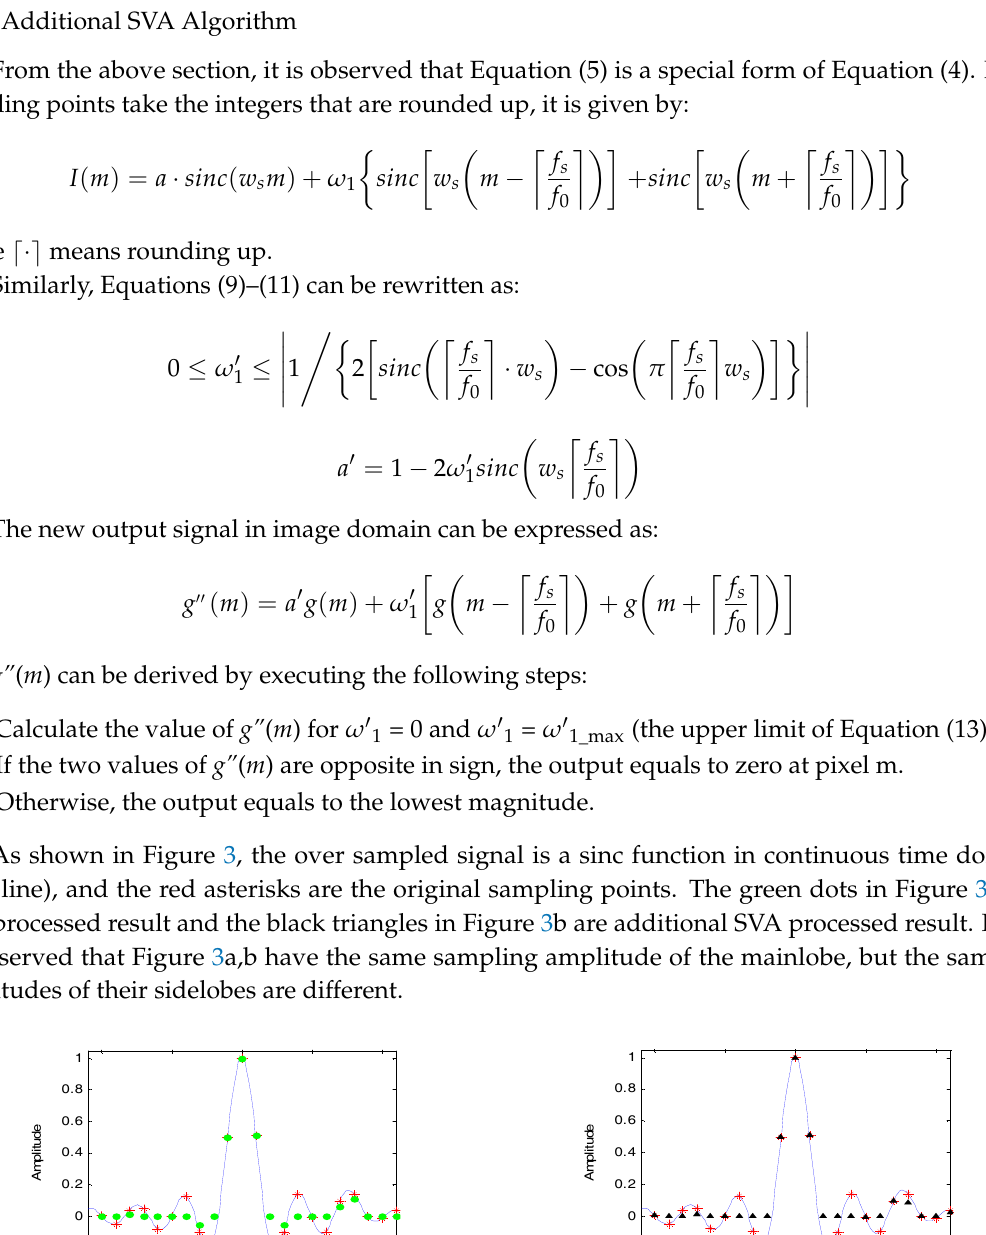
Figure 3. SVA and Additional SVA processed results ( w s = 0.6). ( a ) SVA; ( b ) Additional